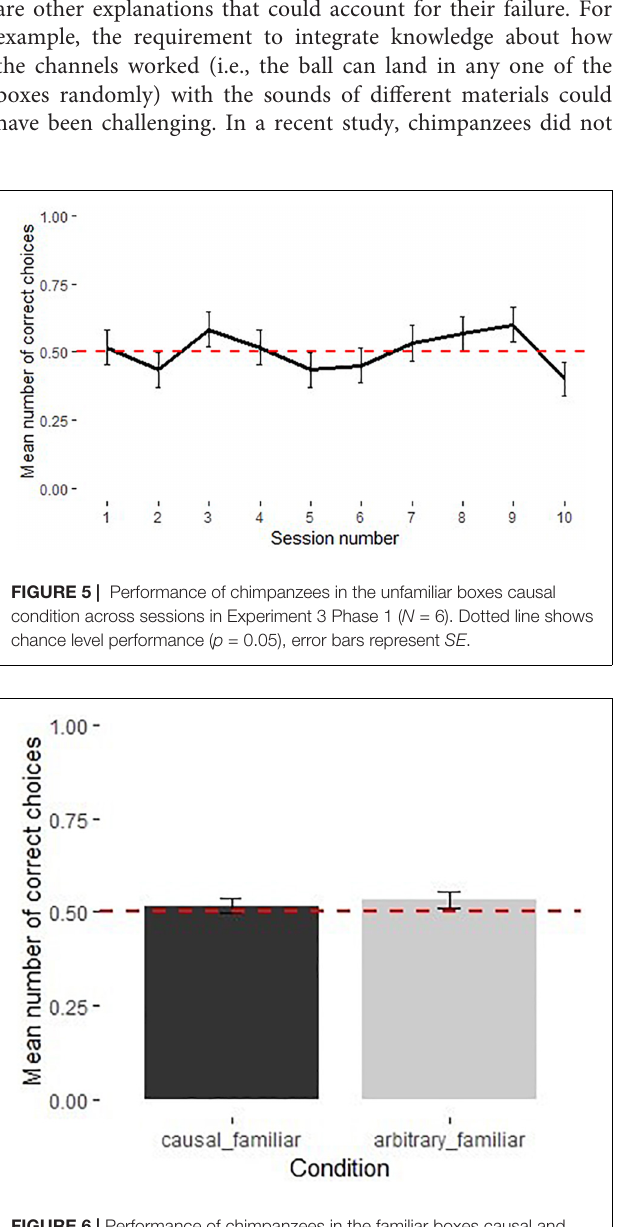
FIGURE 6 | Performance of chimpanzees in the familiar boxes causal and arbitrary conditions in Experiment 3 Phase 2 ( N = 11). Dotted line shows chance level performance ( p = 0.05), error bars represent SE